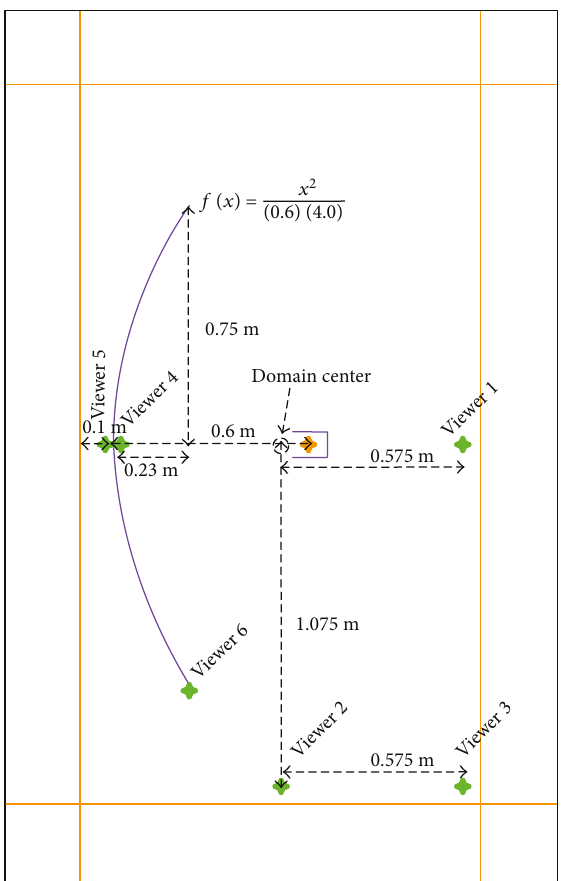
Figure 9: Con fi guration of the parabolic re fl ector. The parabola is described by f x = x 2 / 0 6 0 4 . The viewers are located in strategic points so to measure the quality of the solution. The source is located in the parabola ’ s focus, within the hood feeder.